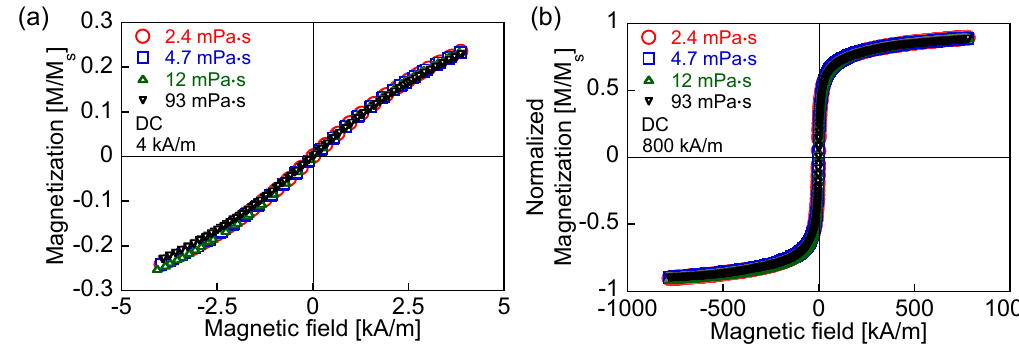
Figure 1. Direct current (DC) hysteresis loops covering field intensities of ( a ) 0–4 kA/m and ( b ) 0–800 kA/m for viscosities of 2.4, 4.7, 12, and 93 mPa ∙ s.